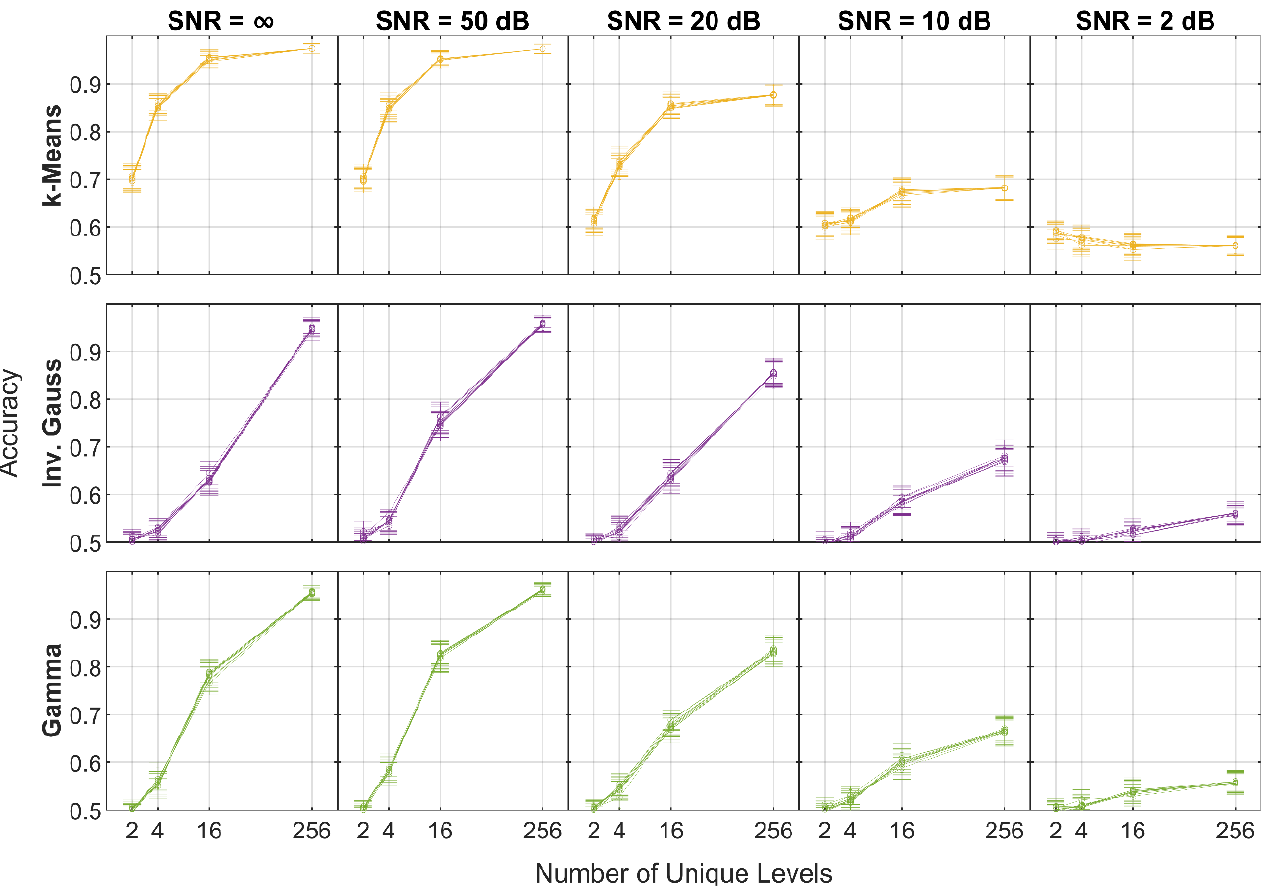
Figure 7. Accuracy of the networks implementing RNG-based quantization scales for 10 different initial seeds.